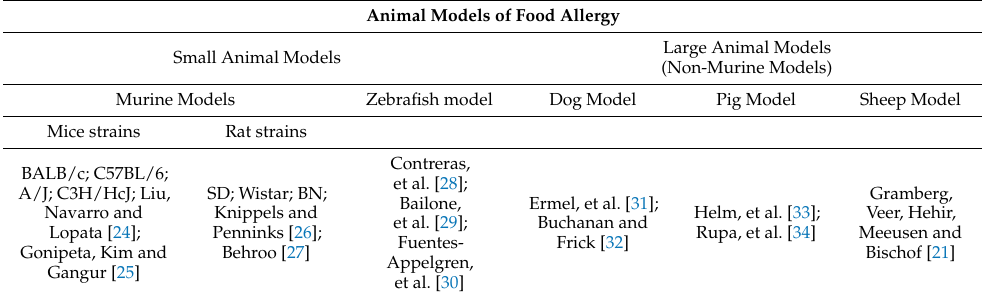
Table 1. General classification of animal food models with proposed references for further reading.